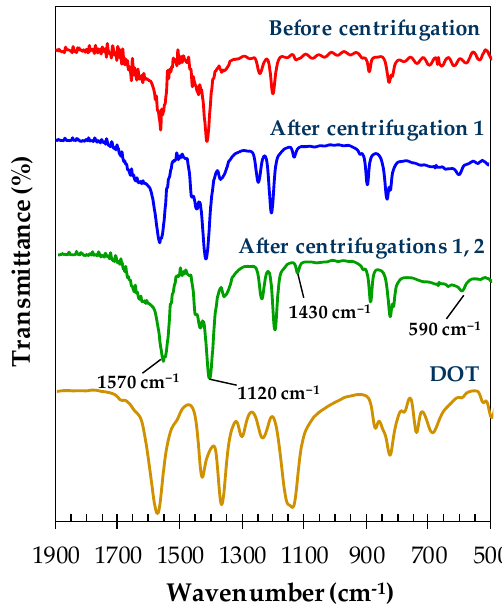
Figure 3. FTIR spectra of Ni-MOF-74 samples from before centrifugation (red), after centrifugation 1 (blue), and after centrifugations 1 and 2 (green), with the spectrum of 2,5-dihyroxyterephtalic acid linker (brown) from [30].